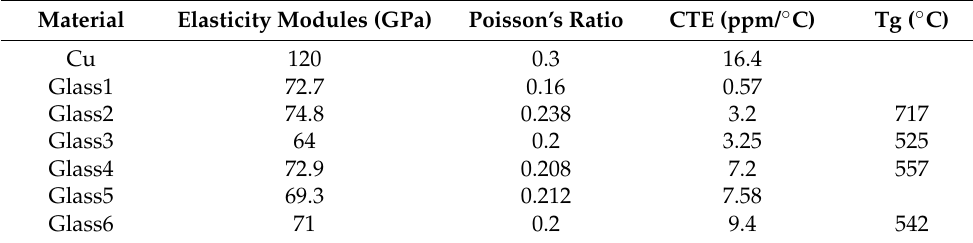
Table 1. Material properties of 3D interconnection structure.